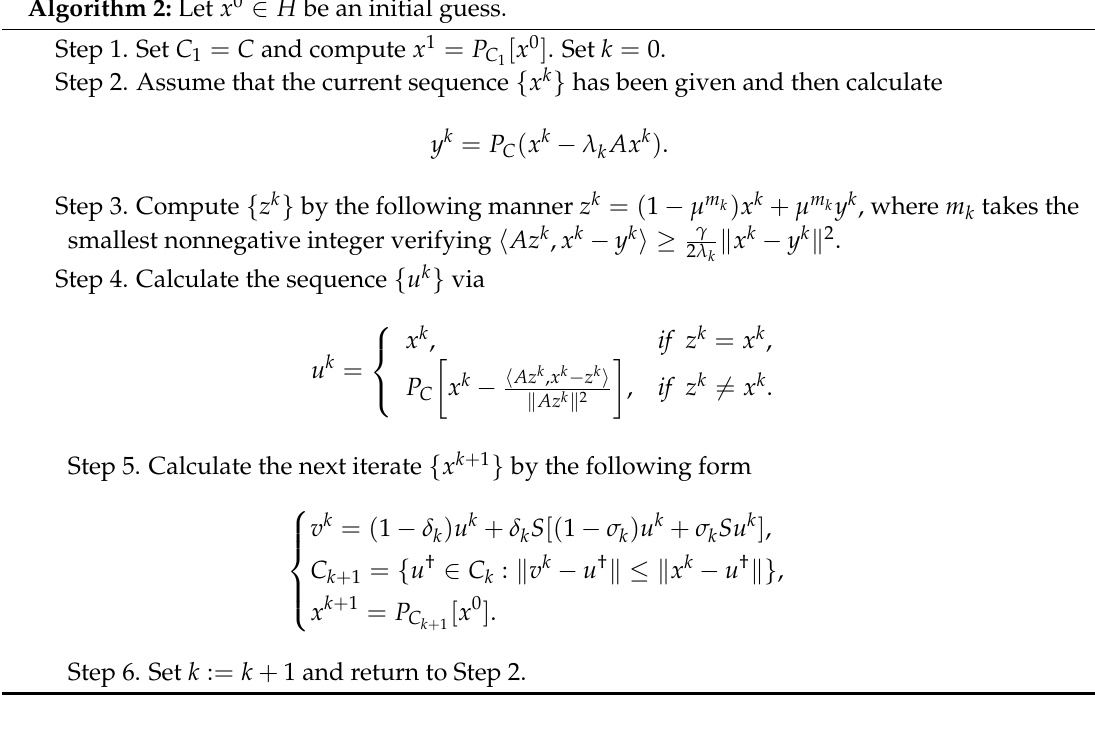
Algorithm 2: Let x 0 ∈ H be an initial guess.